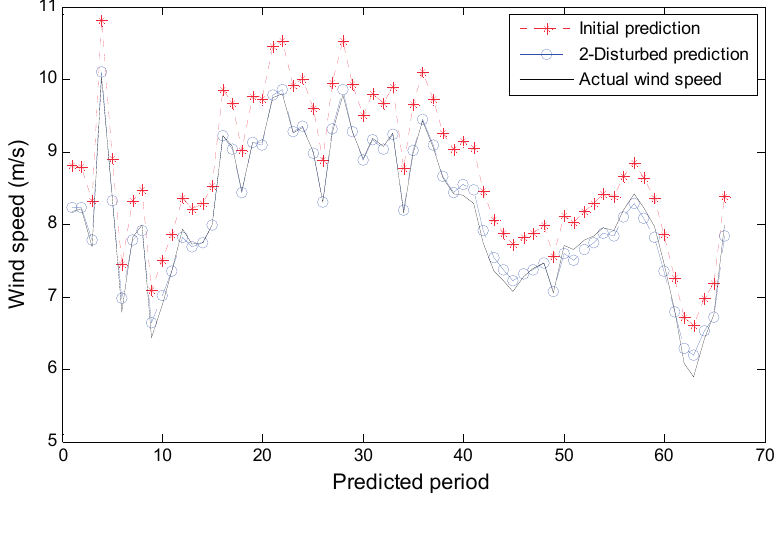
Figure 9. Wind speed forecasting results of the quadratic polynomial generating model when Rayleigh number equals